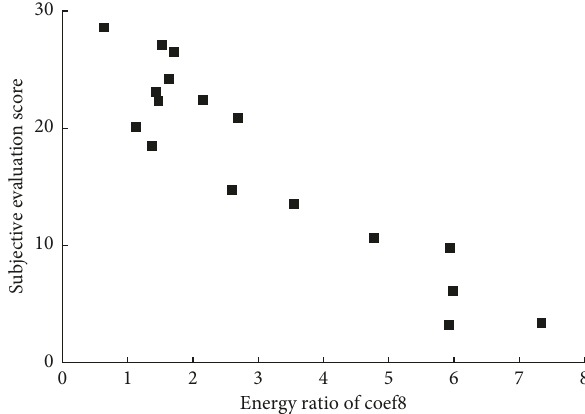
Figure 13: Correlation between the energy ratio coefficient of component 8 and the subjective evaluation value. Figure 10: Correlation between roughness and the subjective